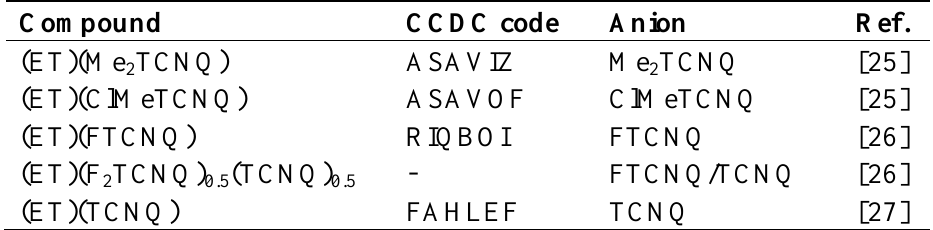
Table 1. ET salts with TCNQ